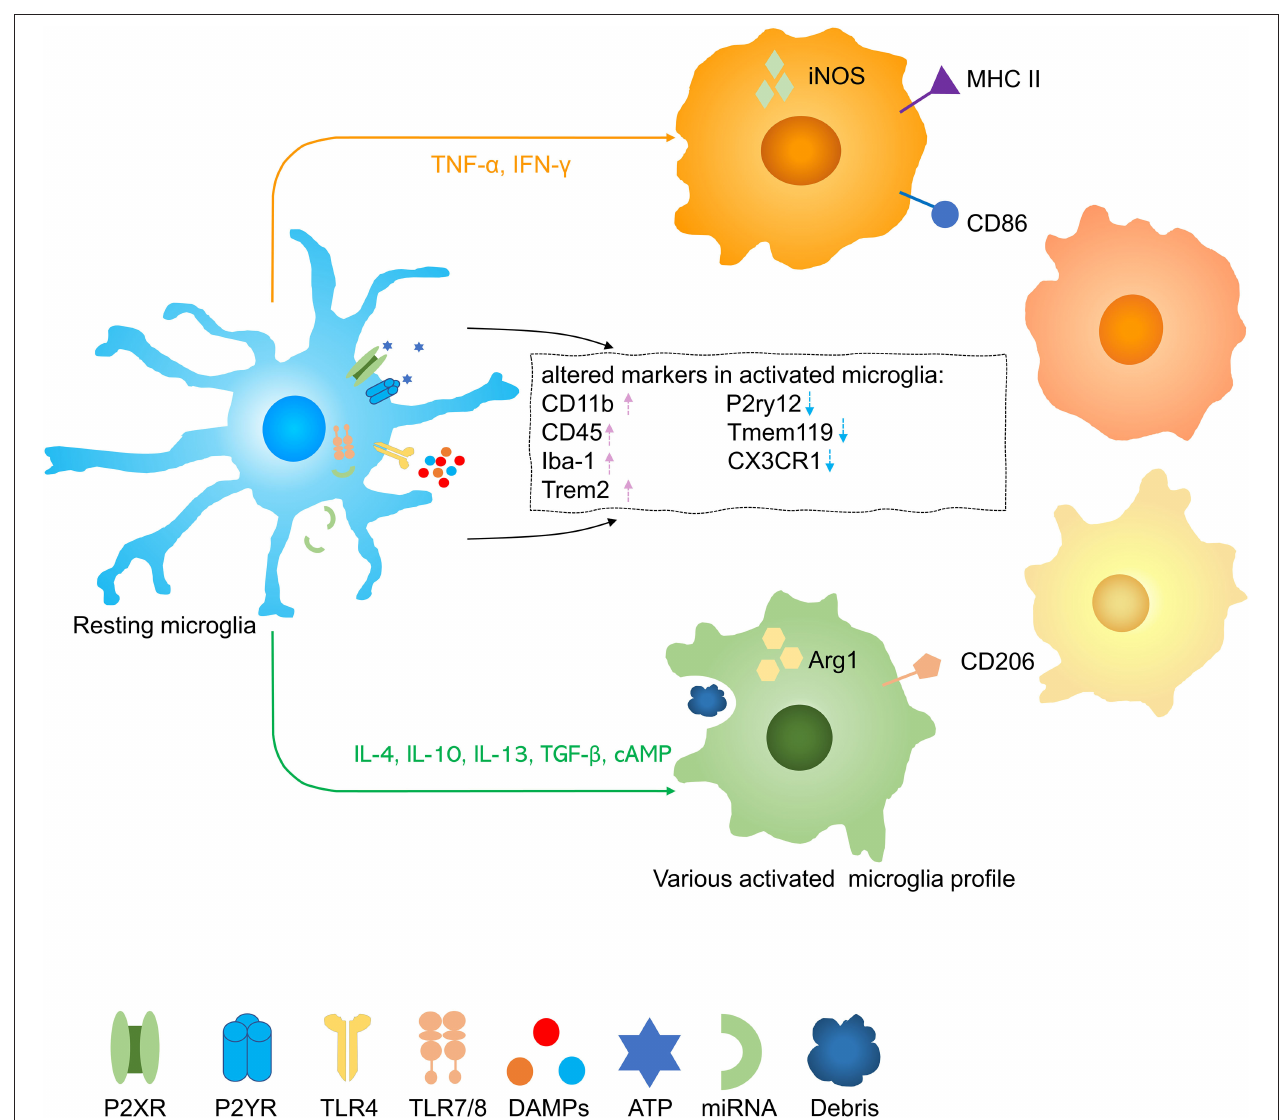
FIGURE 2 | Activation of microglia in spinal cord injury (SCI). Resting microglia are activated into several phenotypes by various stimuli. Pink arrow, upregulation; blue arrow,